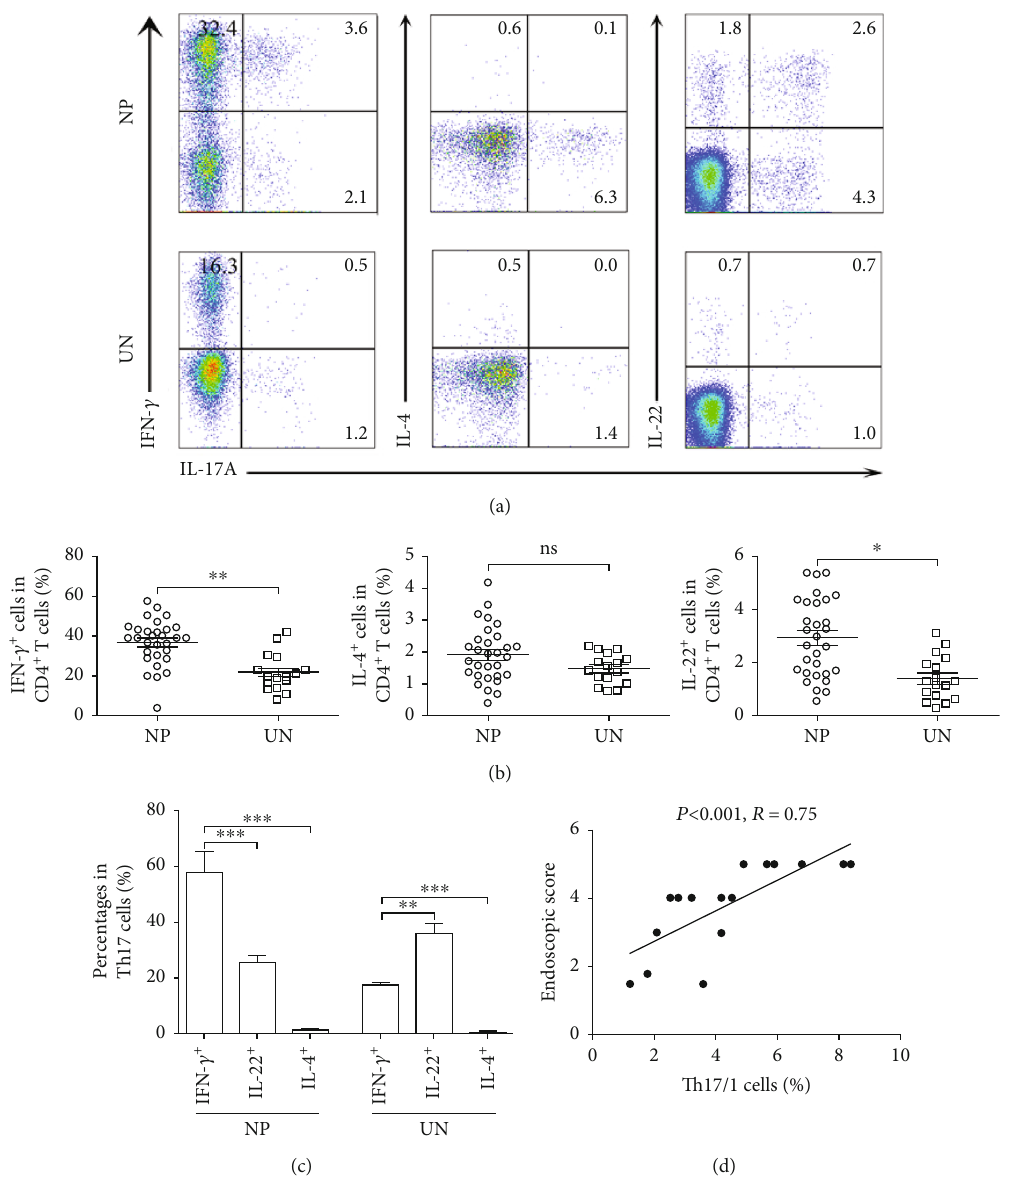
Figure 3: The majority of CD4 + IL-17 + cells coexpressed IFN- γ cells in NP tissues. (a, b) Representative graph and summary data showed the expression of IL-17A, IFN- γ , IL-22, and IL-4 by Th17 cells in NP ( n = 30 ) and uncinate ( n = 16 ) tissues. (c) Summary data showed the expression of IFN- γ + , IL-22 + , or IL-4 + cells in Th17 cells in NP ( n = 30 ) and uncinate ( n = 16 ) tissues. (d) The percentage of Th17/1 cells in NP tissues was correlated with endoscopic scores ( n = 16 ). Correlations were determined by Spearman ’ s rank correlation coe ffi cients. Data were shown as the mean ± SEM . Statistical signi fi cance was determined with the Mann – Whitney test. ∗ p < 0 : 05 ; ∗∗ p < 0 : 01 ; ns: no signi fi cance; NP: nasal polyp; UN: